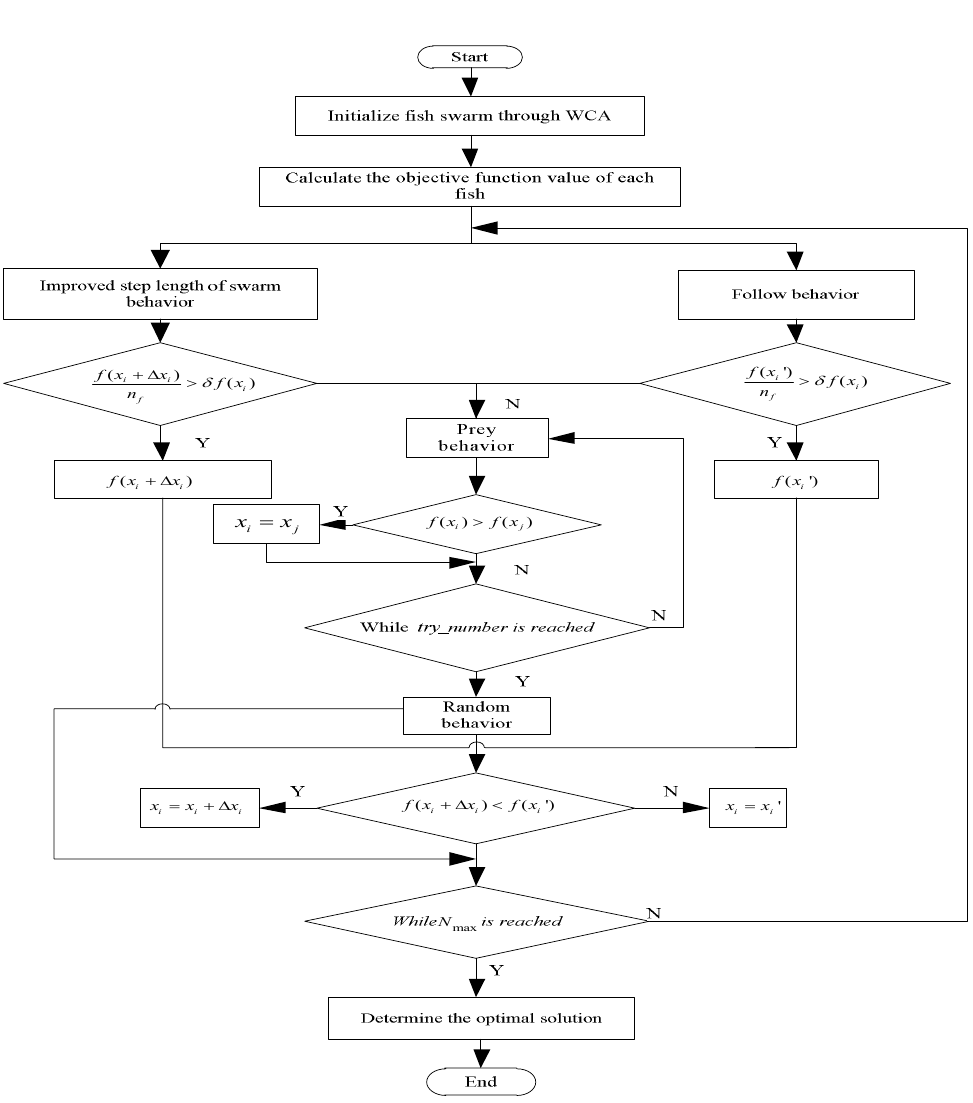
Figure 5. Flow chart of WCA-AFSA.